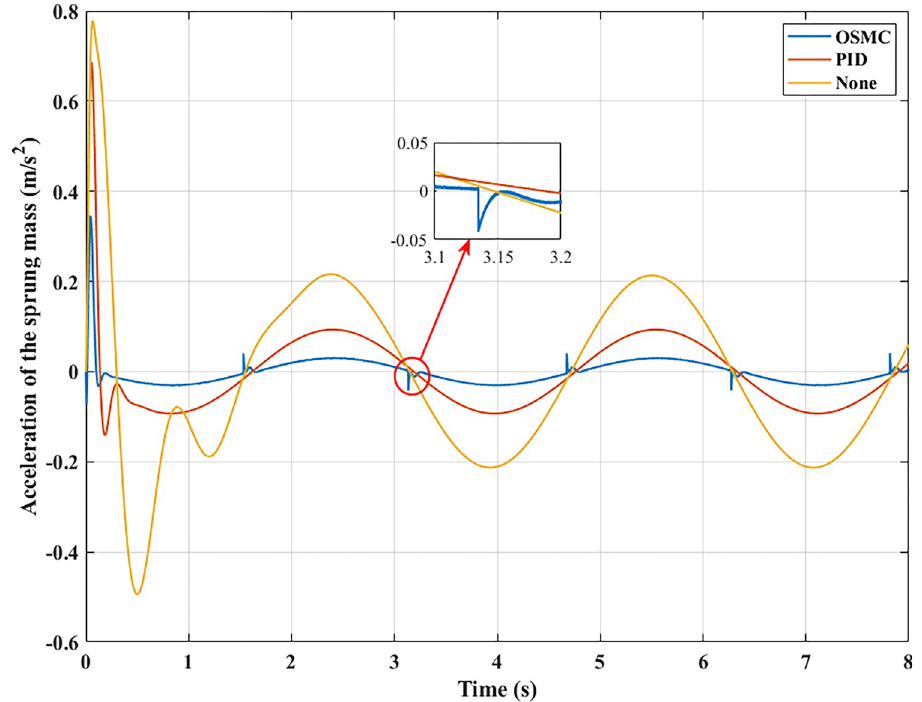
Fig 9. Acceleration of the sprung mass (case